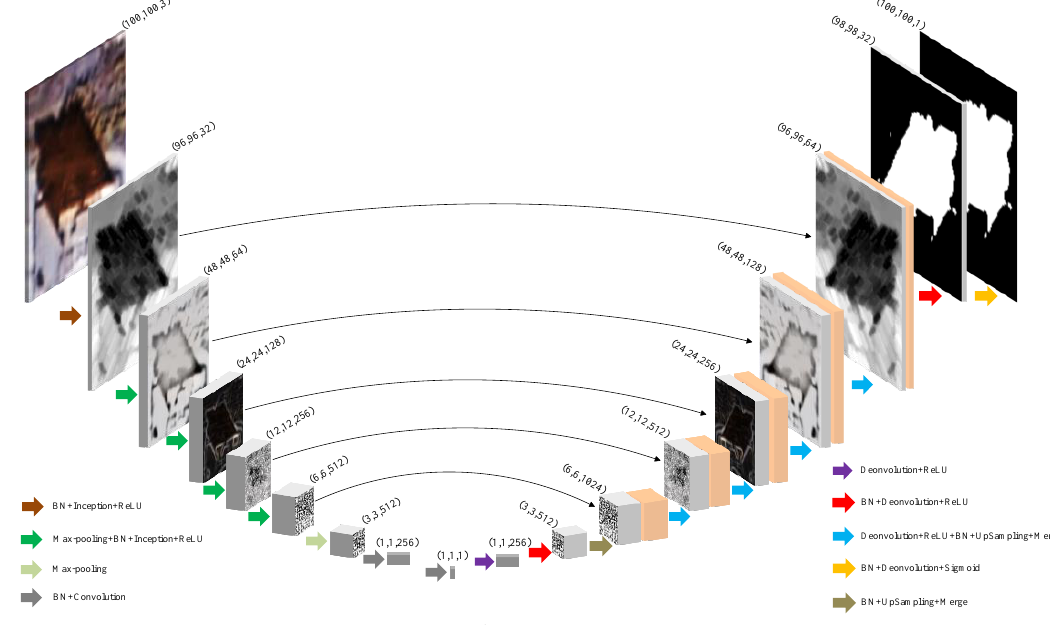
Figure 1. The network framework employed in this